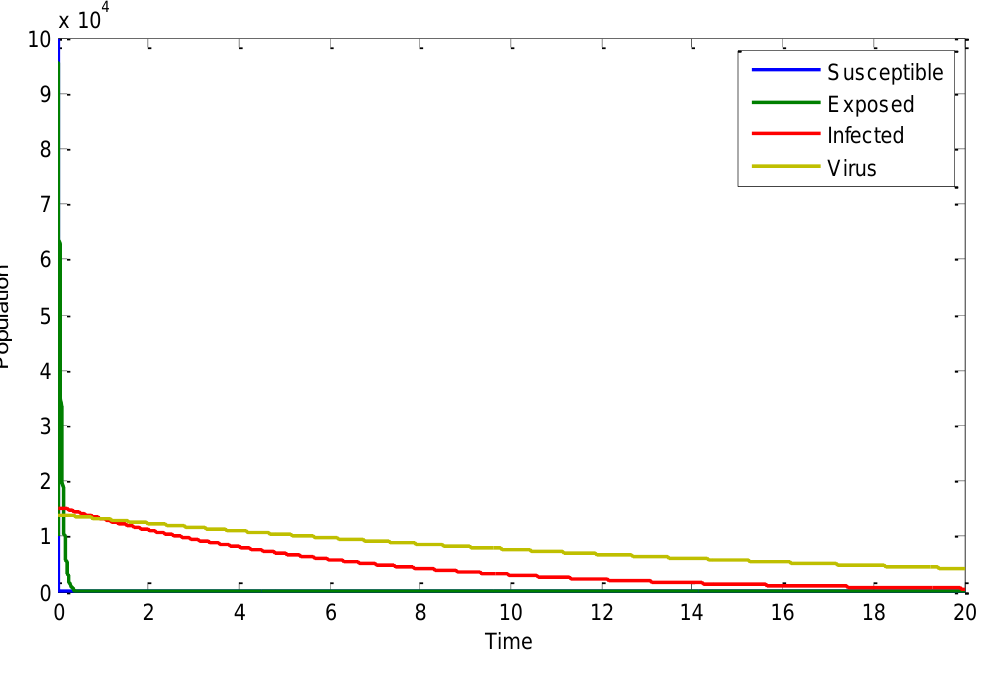
Figure 1. Dynamics of the model.